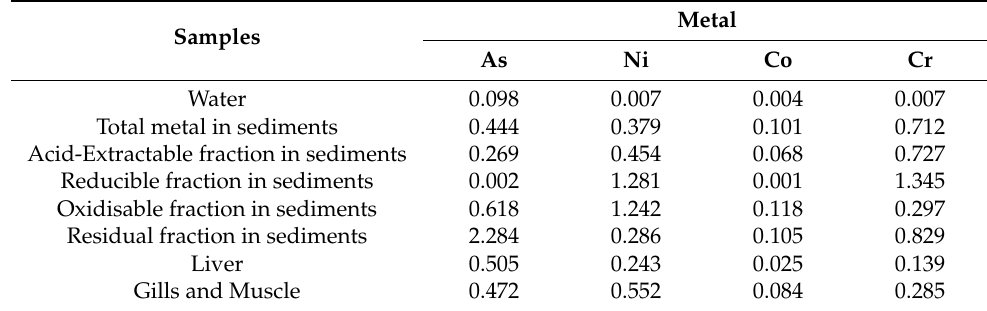
Table A2. Limits of detection ( µ g/L) for As, Ni, Co and Cr in water, sediment and fish samples (n = 10).